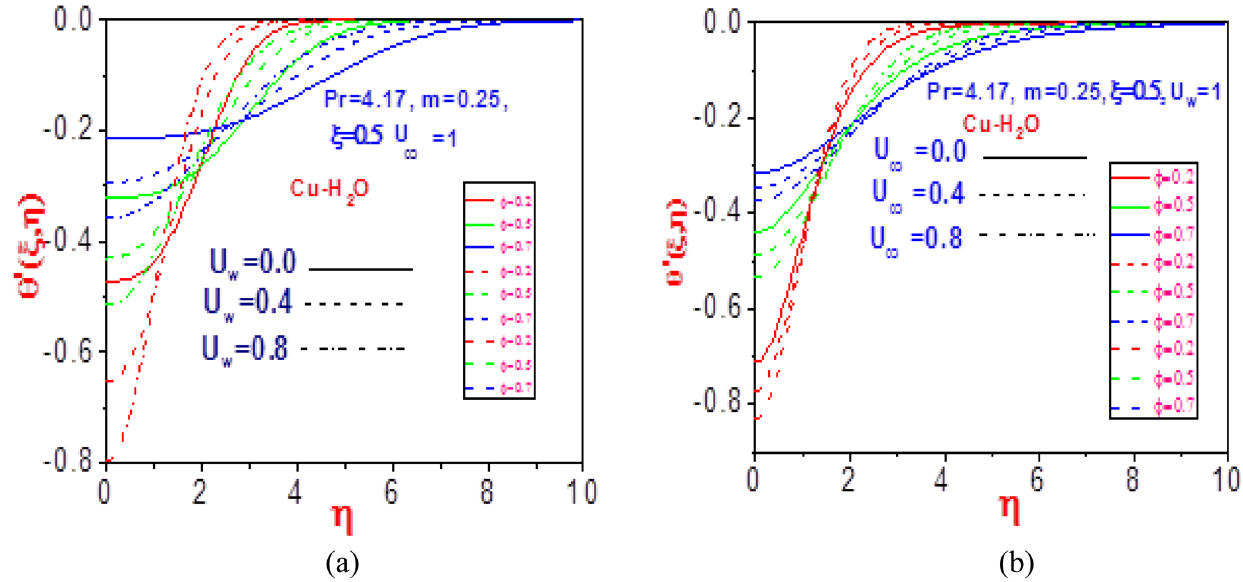
Figure 5. Profiles of missing temperature slope θ ′ (ξ , η) for ( a ) different values of U ∞ with U w = 1 and ( b ) different values of U w with U ∞ = 1